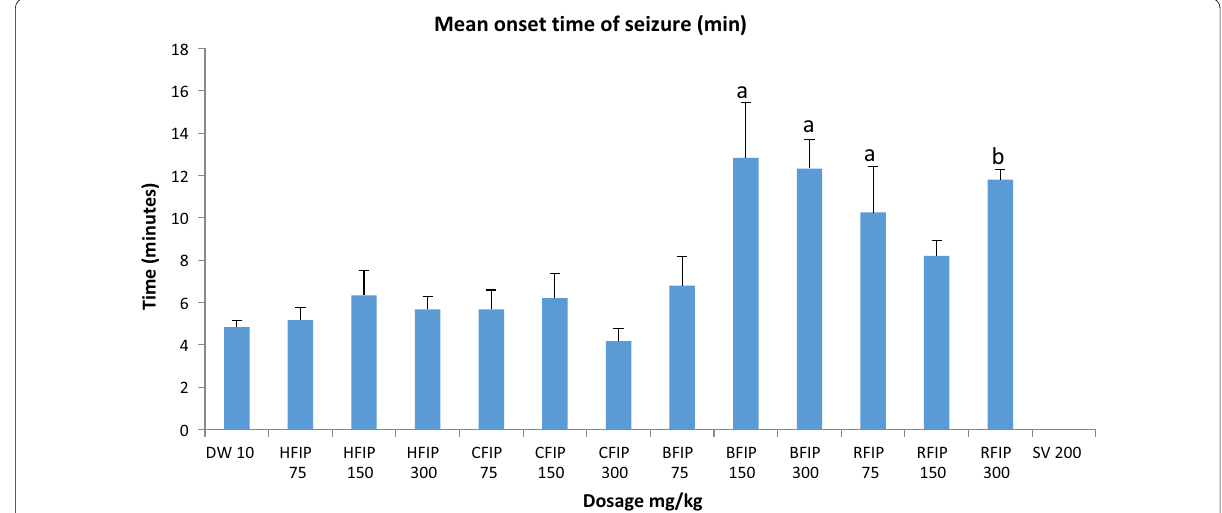
Fig. 2 The effect of fractions of Ipomoea asarifolia on PTZ-induced seizure in mice. DW, distilled water; HFIP, n -hexane fraction; CFIP, chloroform fraction; BFIP, n -butanol fraction; RFIP, residual aqueous fraction; SV, sodium valproate. a